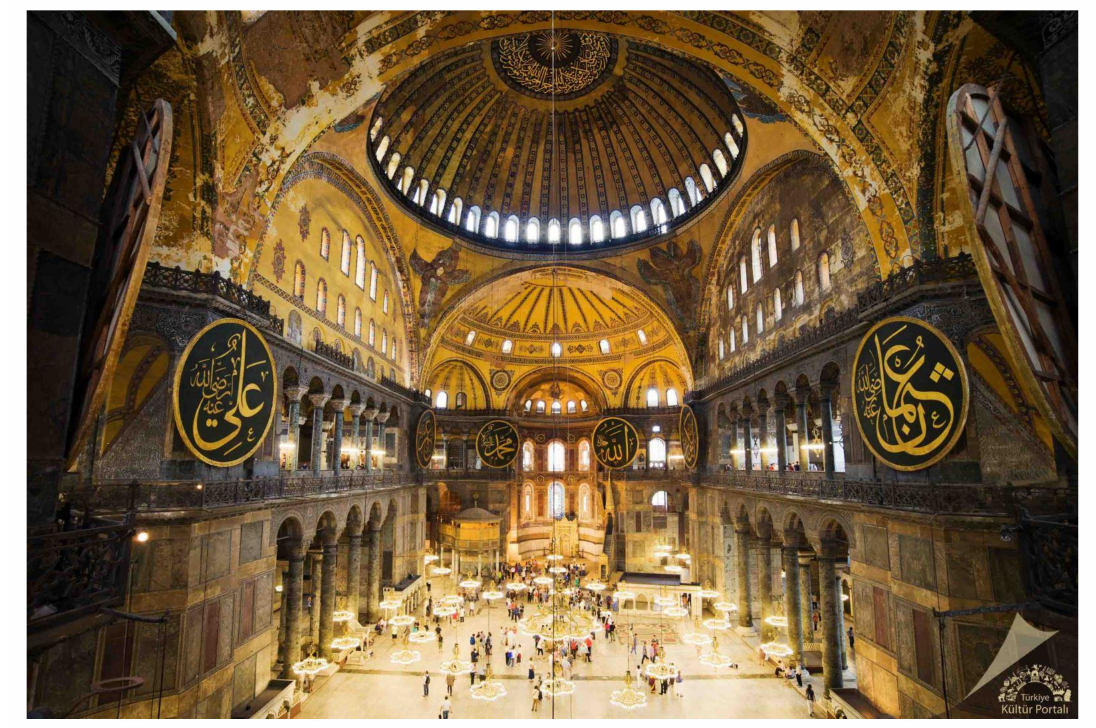
Figure 1. Interior of Hagia Sophia